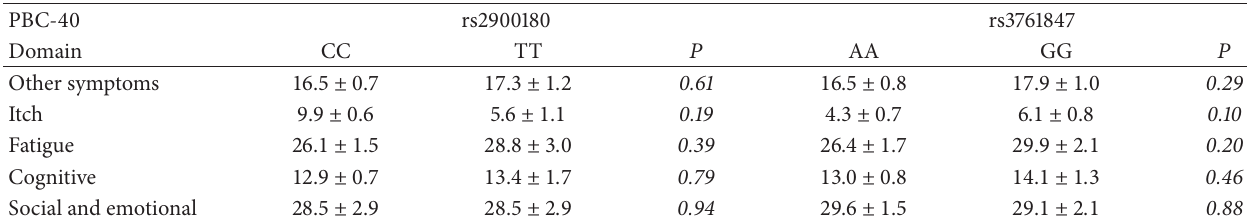
Table 3: Relationship between rs2900180 and rs3761847 TRAF1-C5 polymorphisms and PBC-40